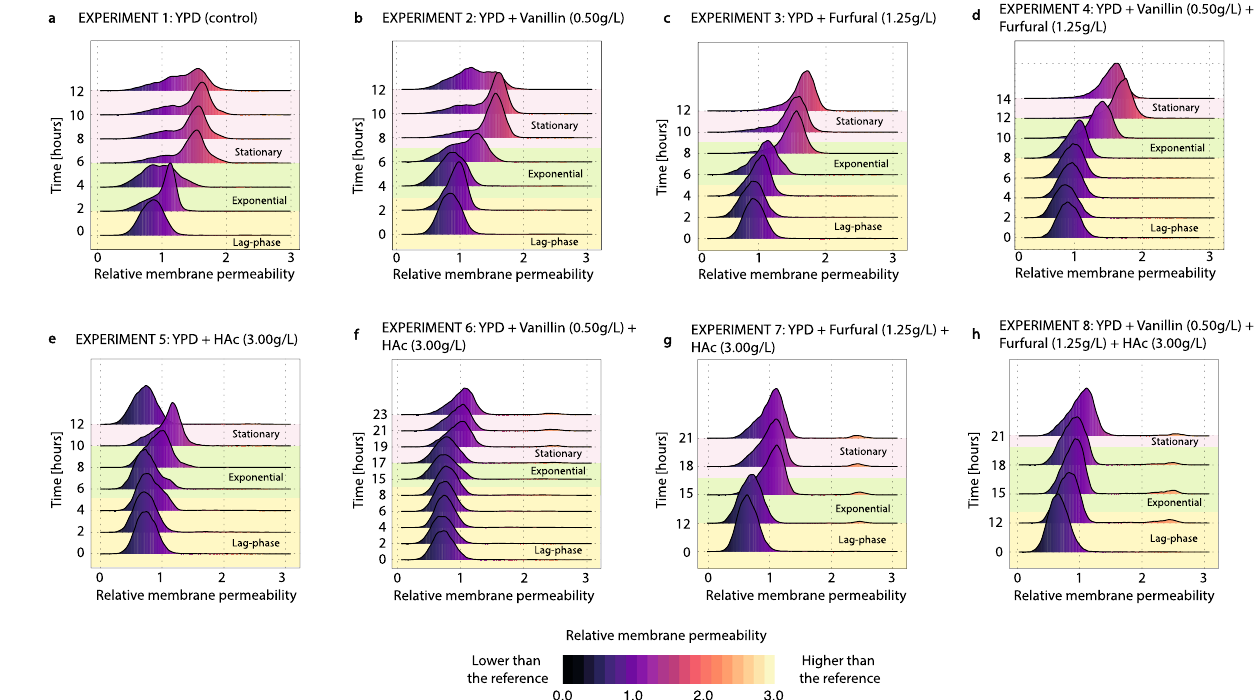
Figure 6. Evolution of the membrane permeability of the cell culture during the experiments 1–8. The membrane permeability (measured using PI) is scaled by the mean of the membrane permeability in experiment 1 at time 0 h ( a ). The colour code indicates how far a population is from the reference point (i.e. orange and yellow indicate a higher membrane permeability than that of the reference population, while black and dark purple indicate a lower membrane permeability than in the reference population). This figure was produced using R 71 . ( a ) YPD control, ( b ) addition of vanillin (0.5 g/L), ( c ) addition of furfural (1.25 g/L), ( d ) addition of vanillin (0.5 g/L) and furfural (1.25 g/L), ( e ) addition of acetic acid (3 g/L), ( f ) addition of vanillin (0.5 g/L) and acetic acid (3 g/L), ( g ) addition of furfural (1.25 g/L) and acetic acid (3 g/L), ( h ) addition of vanillin (0.5 g/L) furfural (1.25 g/L) and acetic acid (3